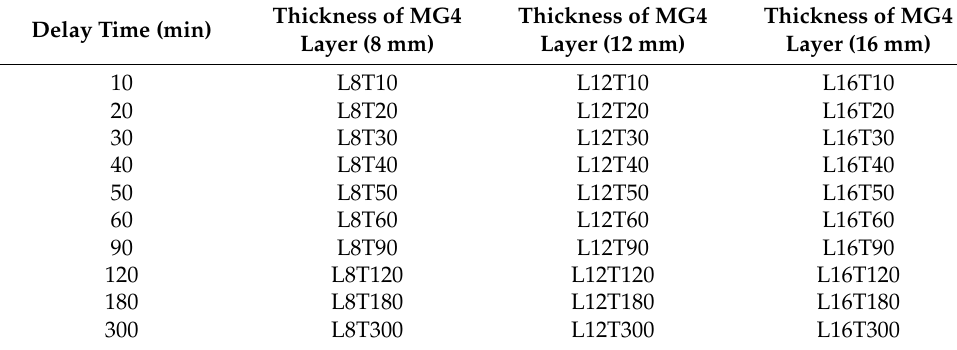
Table 2. Designations of layered cement mortar samples.